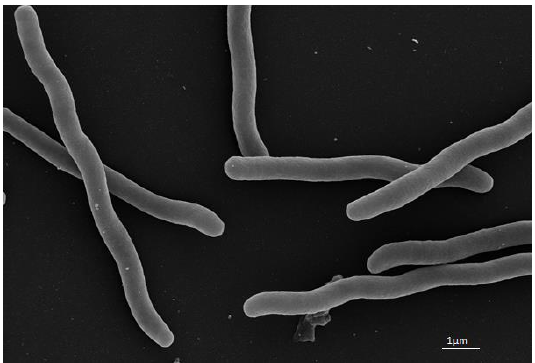
Figure 1. Scanning electron microscopy images of strain WH53 T .